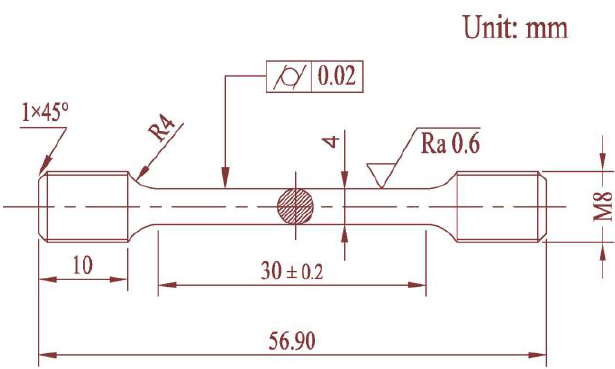
Figure 3. Specimen for tensile test and its dimensions.